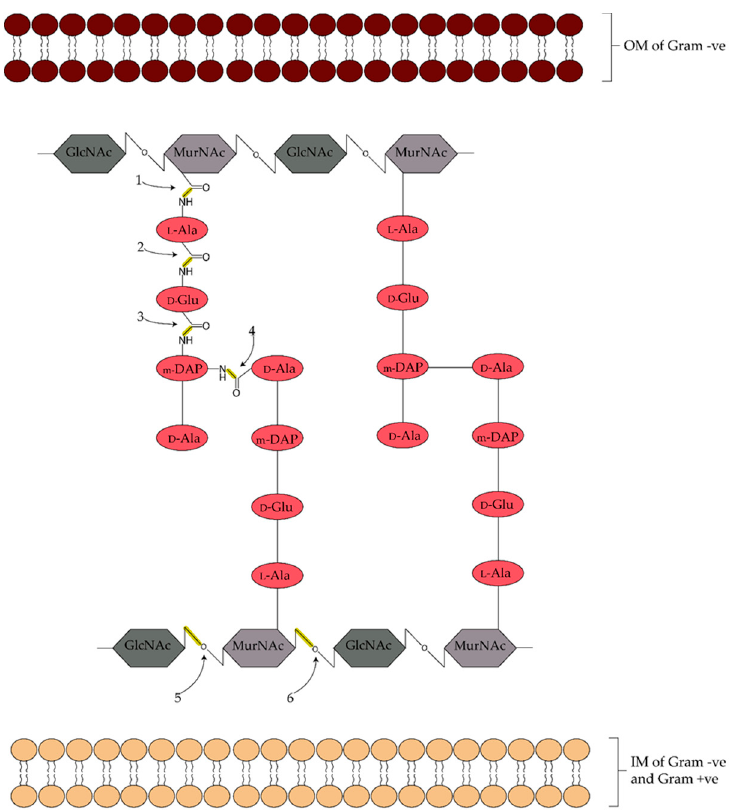
Figure 2. Diagram of the typical cell wall and peptidoglycan structure of bacteria, including the endolysin cleavage sites. The peptidoglycan is composed of repeating sugar units, N -acetylglucosamine (GlcNAc) and N -acetylmuramic acid (MurNAc), which are cross-linked via an interpeptide bridge between the meso -diaminopimelic acid (m-DAP) and D -alanine ( D -Ala) residues of adjacent tetrapeptide chains. The chains also contain L -alanine ( L -Ala) and D -glutamic acid ( D -Glu). Gram-negative bacteria contain an outer membrane (OM) structure not present in Gram-positive bacteria. Both contain an inner membrane (IM) structure. The cleaved bonds and major classifications of endolysin are indicated: (1) N -acetylmuramoyl- L -alanine amidase; (2–4) various endopeptidases; (5) N-acetyl- β - D -glucosaminidase; (6) N-acetyl- β - D -muramidase (lysozyme).